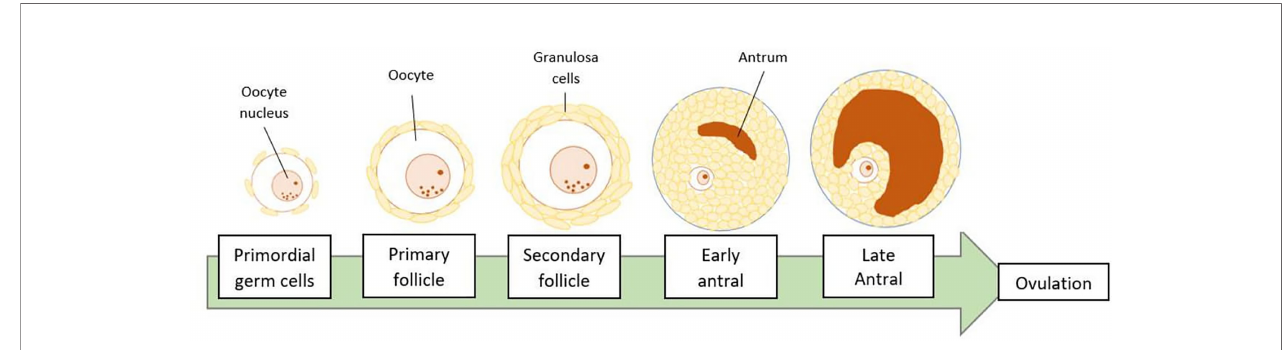
FIGURE 1 | Stages of folliculogenesis. The ovarian follicle will go through primordial, primary, secondary, antral, and pre-ovulatory or late antral developmental stages. Finally, an oocyte is released during ovulation, leaving the remaining ruptured follicle, known as the corpus